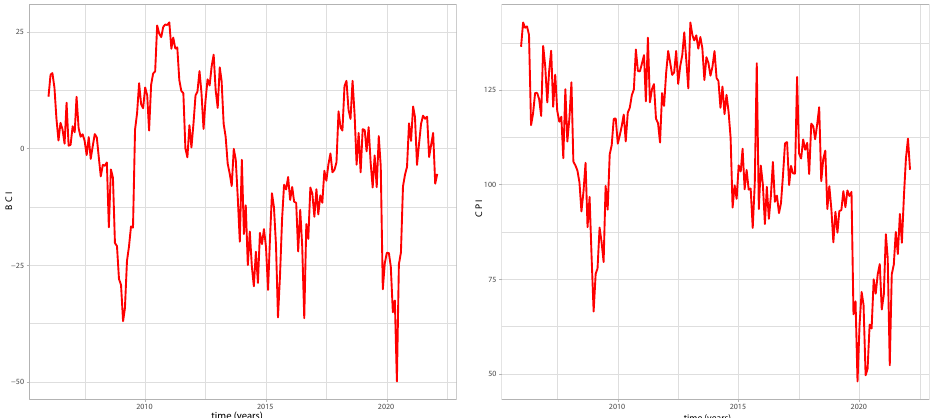
Figure 1. Chilean economic perception from May 2005–June 2022 with BCI ( left ) and CPI ( right ) time